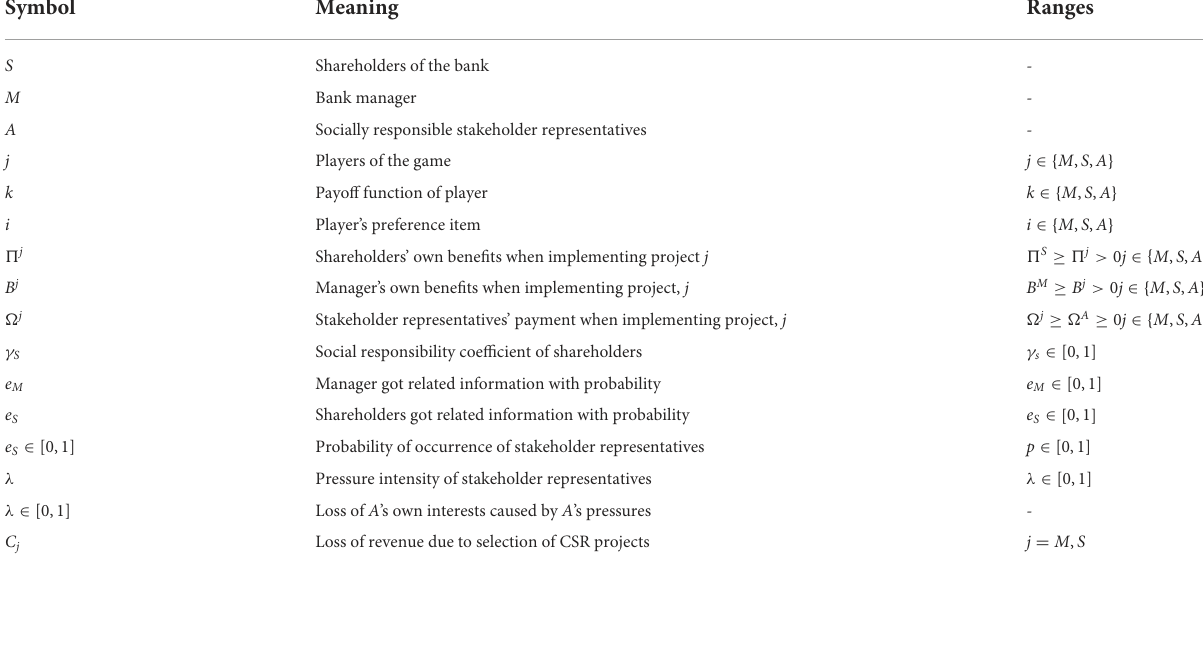
TABLE 1 Description of the main variables of the game. Symbol Meaning